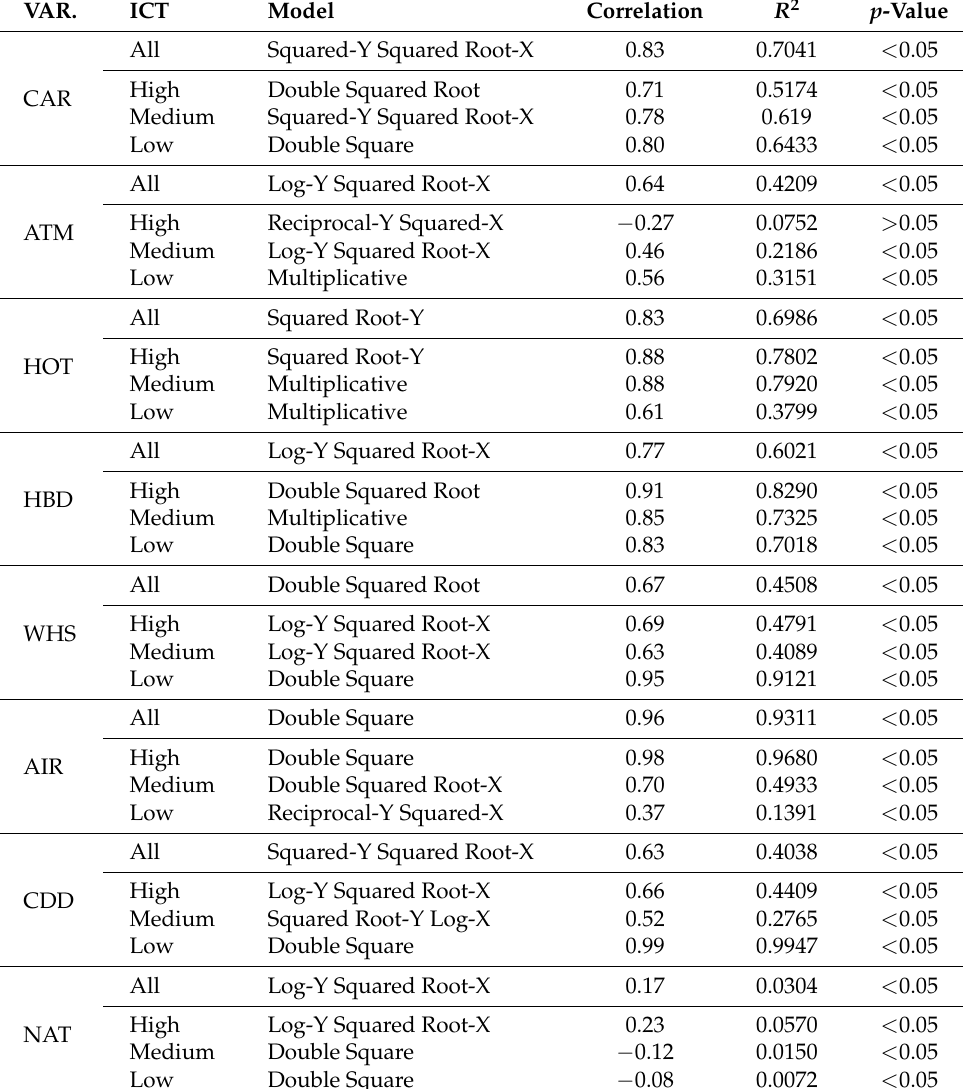
Table A1. Models by ICT